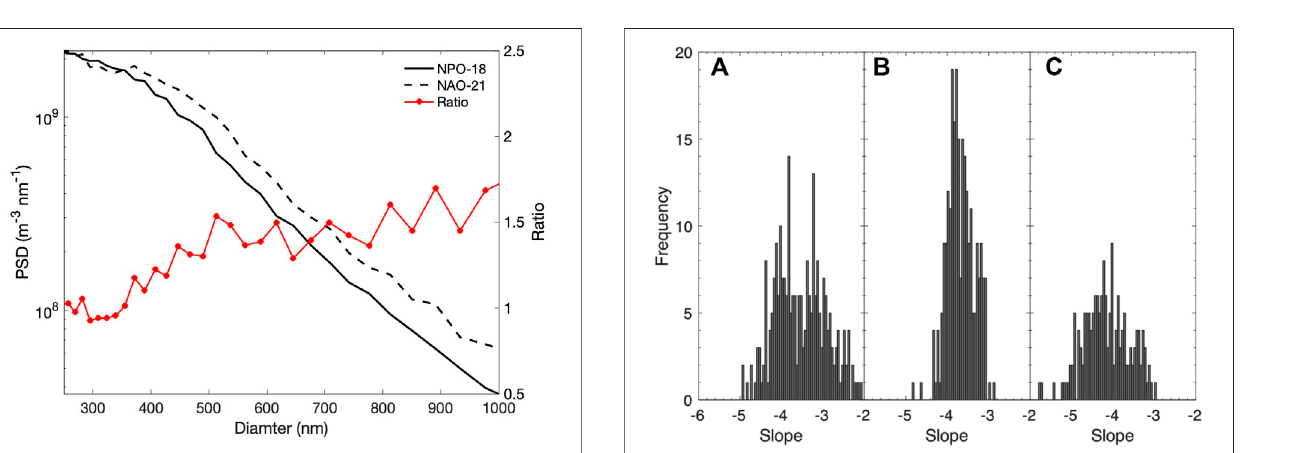
FIGURE 9 | Histogram of the power-law slopes estimated from the particle size distributions measured by (A) ViewSizer 3000, (B) Coulter Counter Multisizer 4e, and (C) LISST-100X during